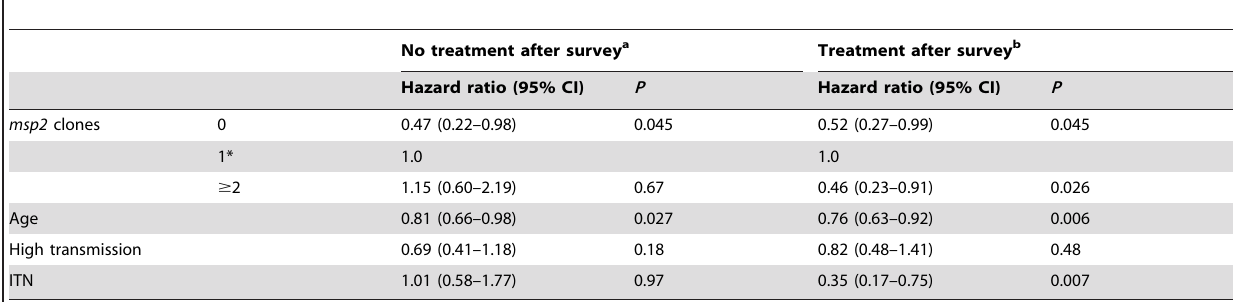
Table 2. Factors associated with risk of subsequent clinical malaria during follow-up with and without anti-malarial treatment after survey.